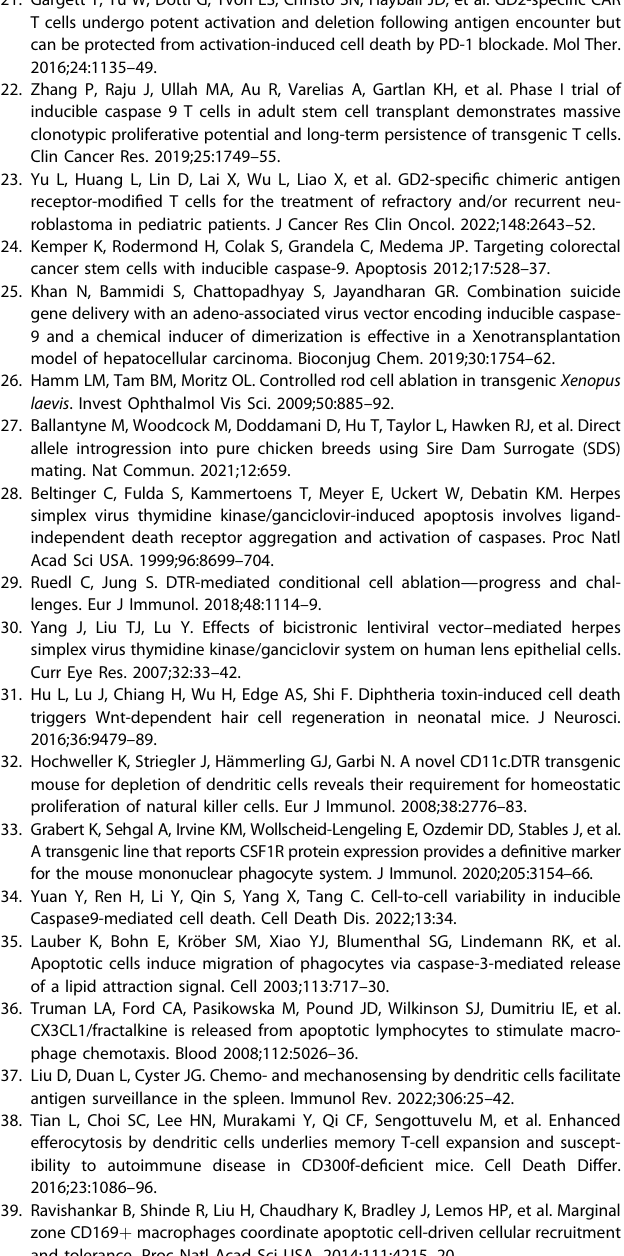
Fig. 5 Macrophages mediate efferocytosis of apoptotic osteoblasts. A Lumbar vertebrae from vehicle- or AP (50 µg/g)-treated OCN- Cre + / − iCasp9 + / + mice showing multiplex immuno fl uorescent (IF) staining for EGFP (green), Ly6G (blue), TRAP (magenta) and F4/80 (red) expression. Arrowheads indicate F4/80 + macrophages directly associated with bone or EGFP + osteoblasts. COJ — chondro-osseous junction. Quanti fi cation of B the number of Ly6G + signals directly associated with trabecular bone or EGFP + bone-lining cells using the multiplex IF images ( A ). C Quanti fi cation of TRAP + surface (S) per trabecular bone surface (Tb.BS) using D colorimetric TRAP (pink) assay in combination with immunohistochemical detection of EGFP (brown). Arrowheads indicate EGFP + signal within TRAP + osteoclasts in the primary spongiosa (Region 1) that were quanti fi ed in ( E ). F Quanti fi cation of percent F4/80 + surface (S) per Tb.BS using the multiplex IF images ( A ). G Representative images of dual EGFP and F4/80 staining. Yellow- and blue-boxed panels are magni fi ed z-stack images of regions in “ AP ” showing F4/80 + cells encapsulating EGFP + remnants (arrowheads). H Number of F4/80 + cells containing EGFP + remnants located on or within one cell from bone surfaces. I IF images showing expression of EGFP and OCN in OCN-Cre + / − iCasp9 + / + mouse calvaria. J Flow cytometry analysis of bone marrow-derived macrophages (BMMs) cultured for 4 h with calvarial osteoblasts (COBs) that were pre-treated with AP/vehicle. Statistical signi fi cance was determined using two-way ANOVA with Sidak ’ s multiple comparisons test or paired t -tests comparing AP-treated culture with vehicle-treated control from the same animal. * p < 0.05. Error bars represent standard deviation. n = 3 – 4 mice/group. Scale bar: 50 µm ( A , D , G ), 20 µm ( I